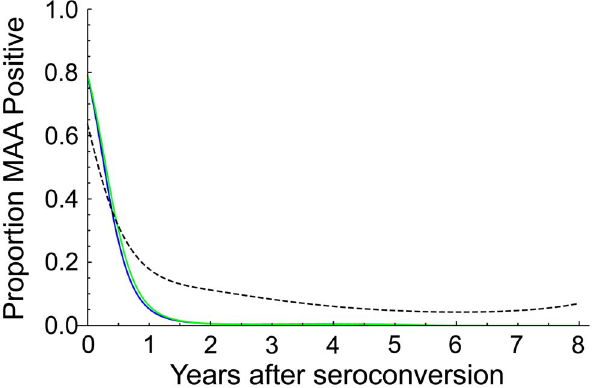
Figure 2. Proportion of samples classified as MAA positive as a function of the duration of HIV infection. Probability curves are shown for the two MAAs described in Figure 1. A probability curve is also shown for the limiting antigen avidity assay (LAg-Avidity assay cutoff , 1.5 OD-n) alone [10]. Key: blue line, MAA with the high resolution melting (HRM) diversity assay; green line, MAA with sequence ambiguity; dotted line, LAg-Avidity assay alone.